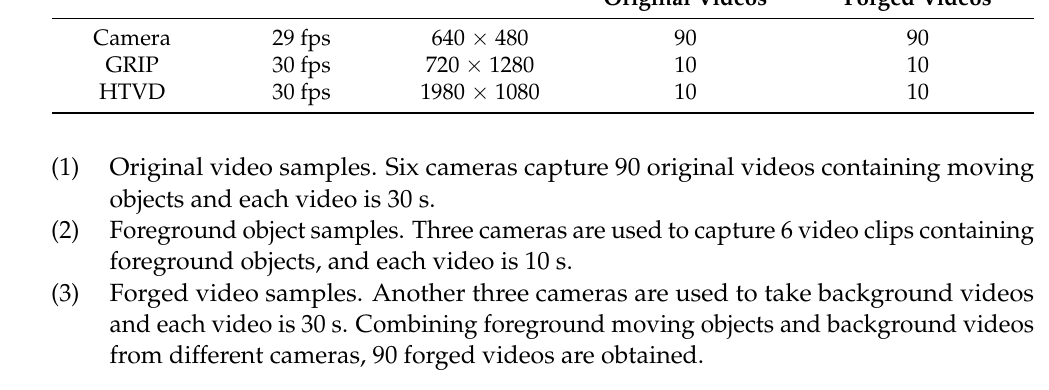
Table 1. The information of the video database. Source Frame